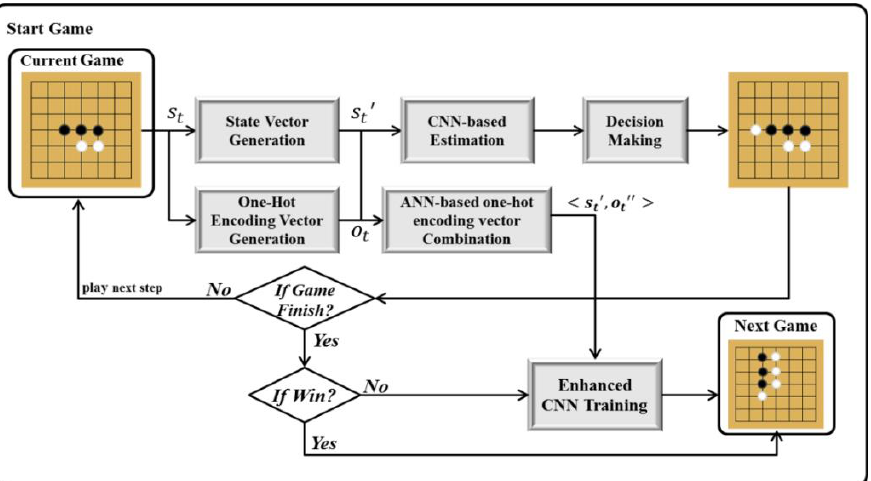
Figure 1. Proposed self-teaching Gomoku